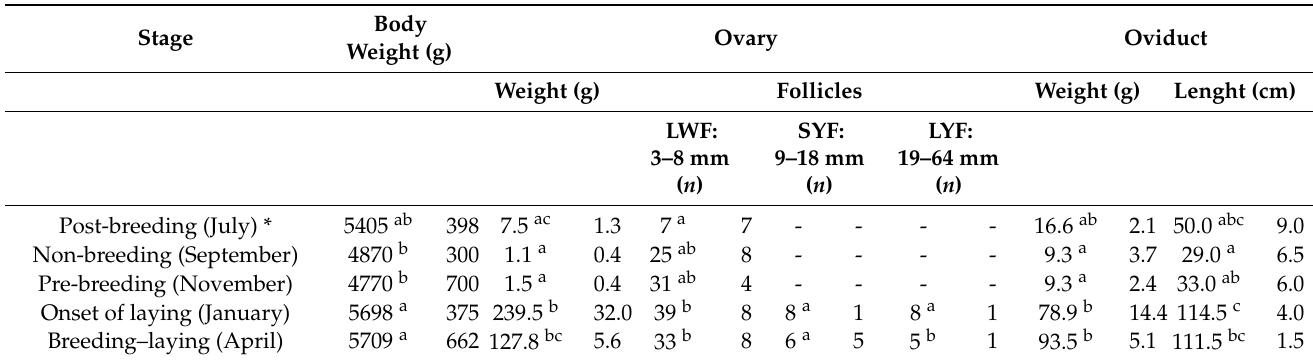
Table 2. Body weight, ovary and oviduct characteristics (median, interquartile range) in 2-year-old Zatorska female geese ( n = 5/stage) during the different stages of the annual period.